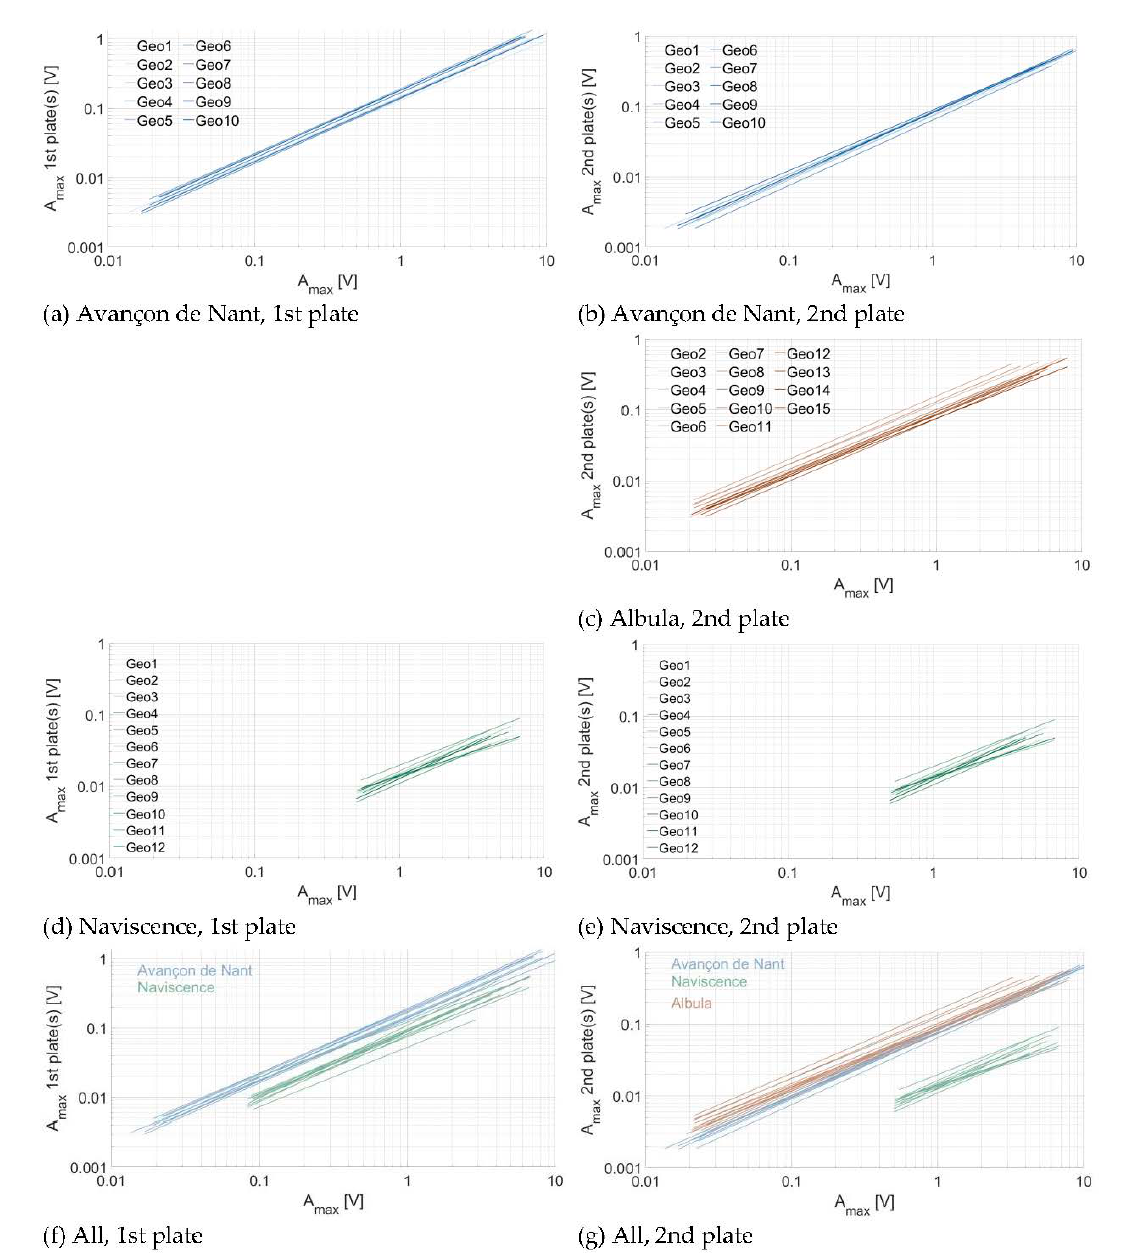
Figure 12. Energy propagation across plates computed for individual plates ( a , b ) at the Avançon de Nant, ( b ) at the Albula, ( c , d ) at the Naviscence, and ( f , g ) for all three measuring stations together.